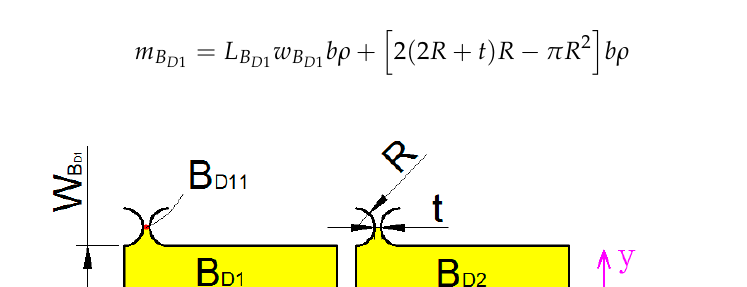
Figure 17. Unit 𝐵 (cid:3005) structure.